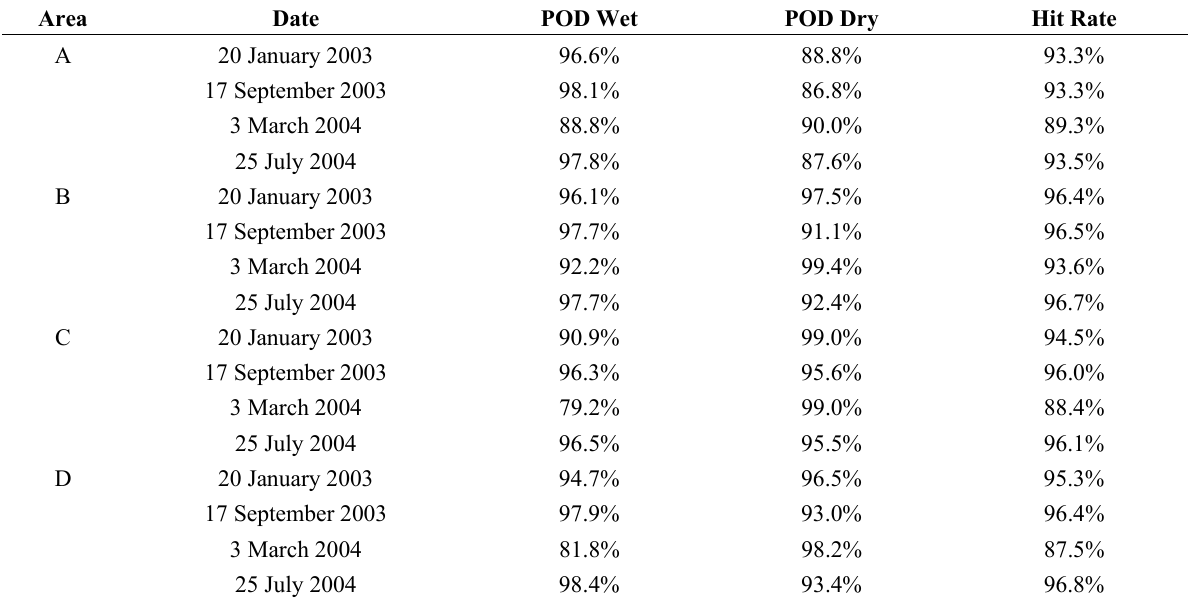
Table 5. Probability of Detection (POD) and Hit Rate statistics for the inundated area comparison.